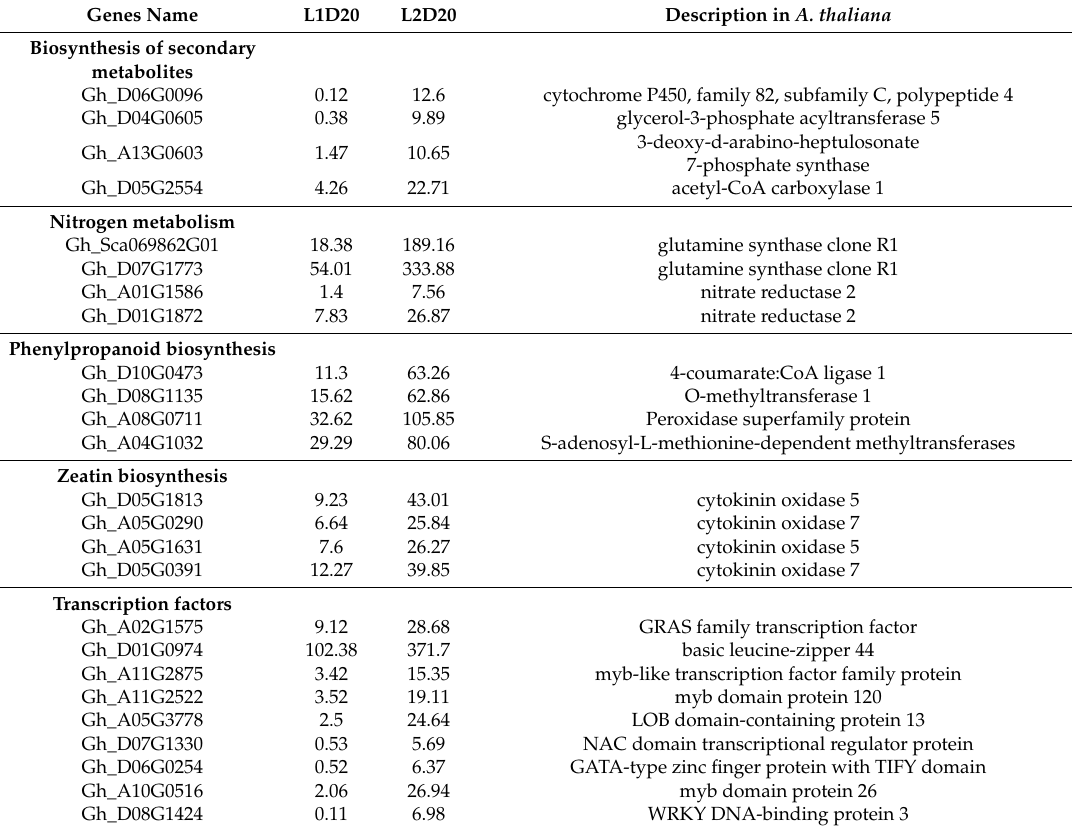
Table 4. FPKMs and functional categories of genes significantly downregulated in L1 on